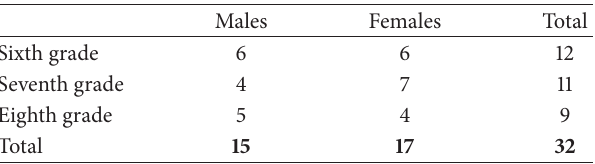
Table 2: Sex and grade of students participating in menu labeling interviews ( 𝑛 = 32